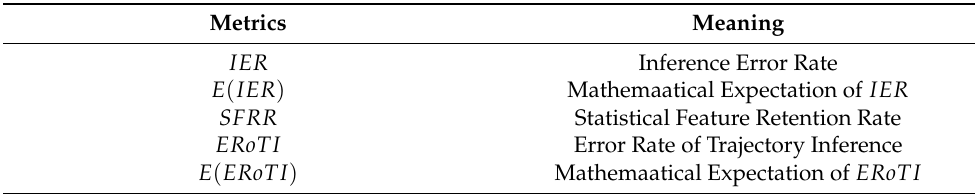
Table 3. Metrics used in this